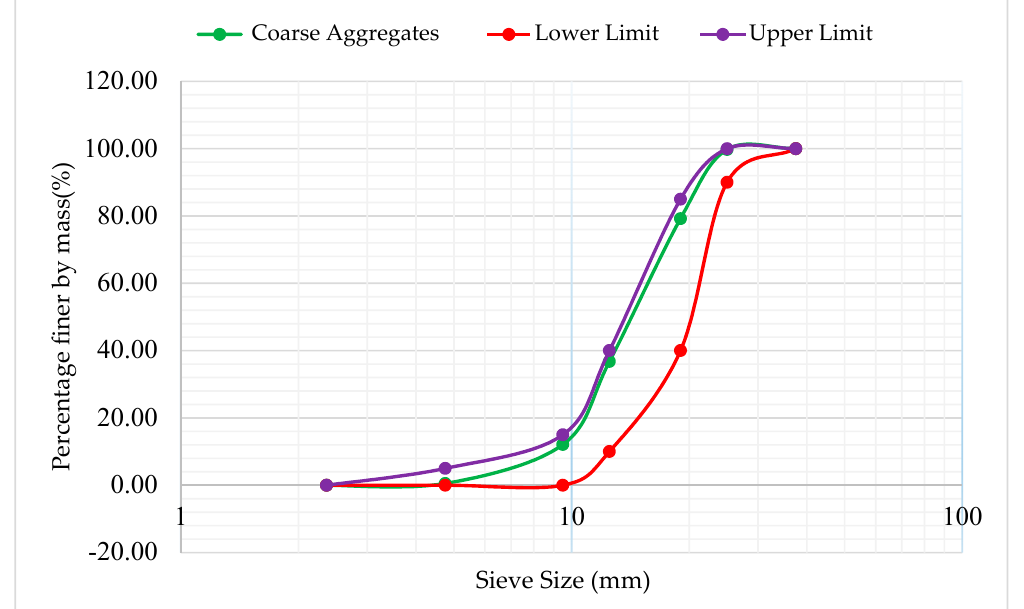
Table 5 . Physical properties of coarse aggregates.